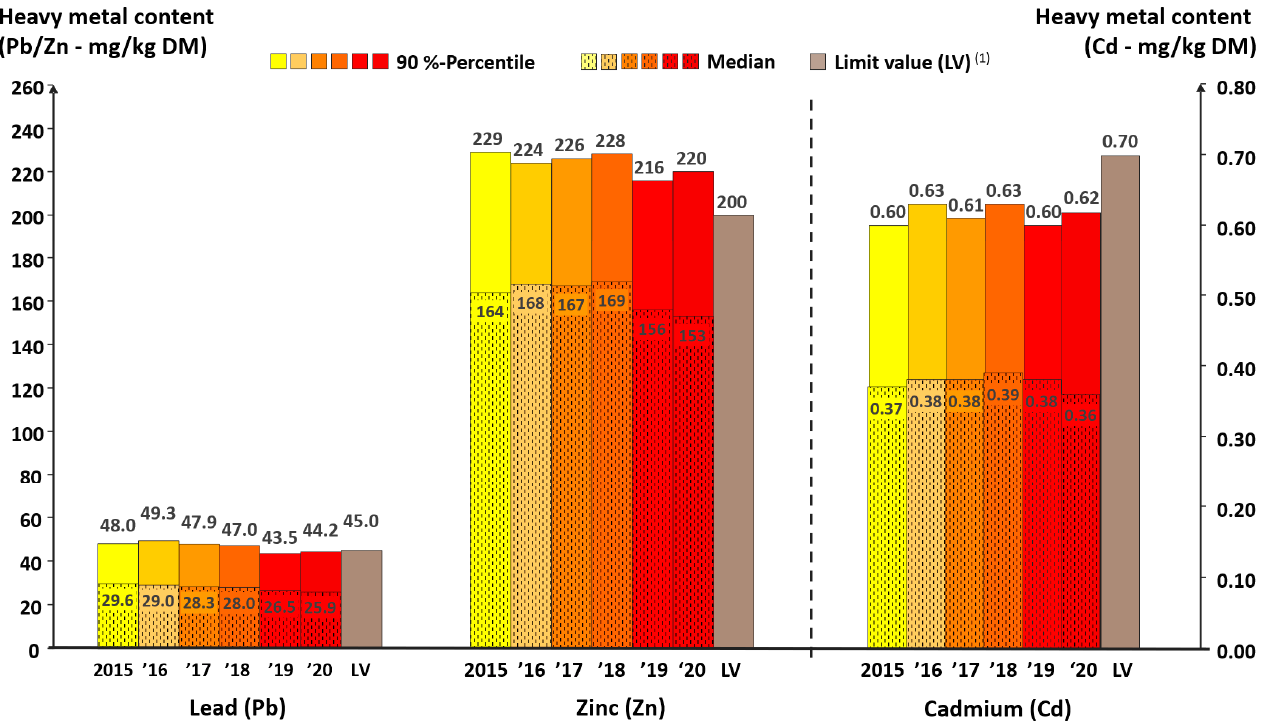
Figure 2. Sensitivity of selected parameters in the parameter group “heavy metals” regarding the suitability of quality-assured biowaste composts without upstream anaerobic digestion (composts according to RAL-GZ 251 Compost from BGK) for organic farming (1).(2) . (1) Limit values ( ≤ ) according to EU-ÖkoV—EU Organic Farming Regulation (VO (EC) 889/2008, Annex 1 resp. 2021/1165, Annex 2). (2) n = 1856 in 2015, n = 1857 in 2016, n = 1843 in 2017, n = 1900 in 2018, n = 1874 in 2019 and n = 1899 in 2020—according to data BGK (2016–2021).